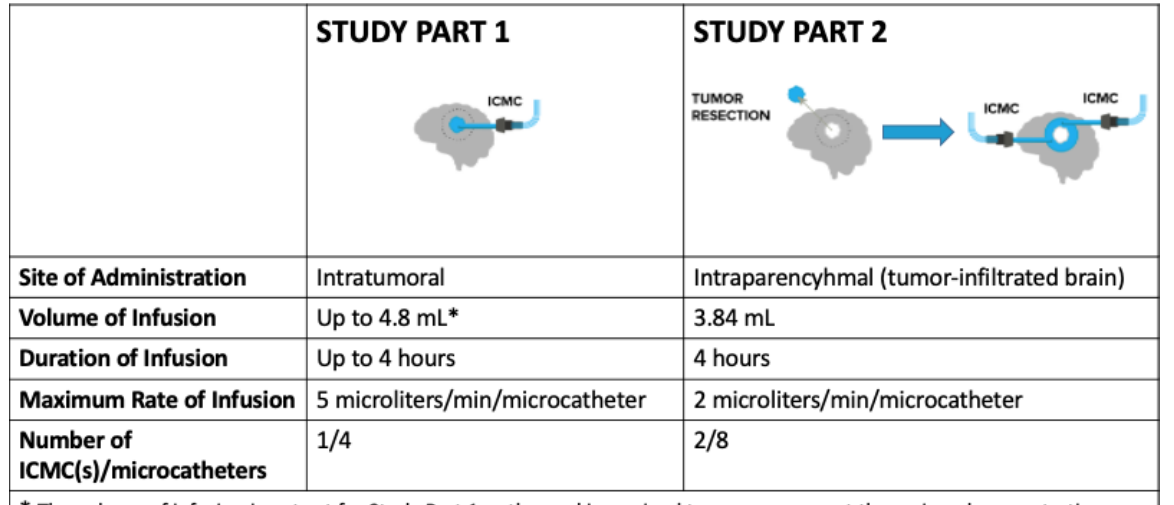
Figure 3. This dynamic two-part study design allows for variations in volume and rate of infusion while the concentration at the assigned dose level is held constant. This allows investigators to adjust infusion parameters for tumors of various sizes and physical characteristics such that they are uniformly infused with the same concentration of OS2966.